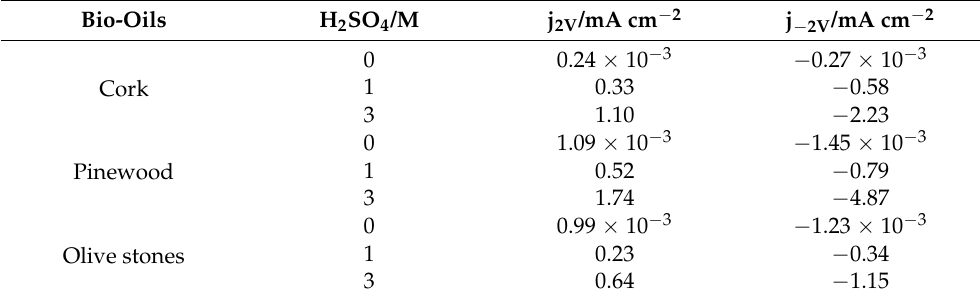
Table 4. Current densities recorded at potentials of 2 V and − 2 V in the CVs of the bio-oil samples with different H 2 SO 4 concentrations.